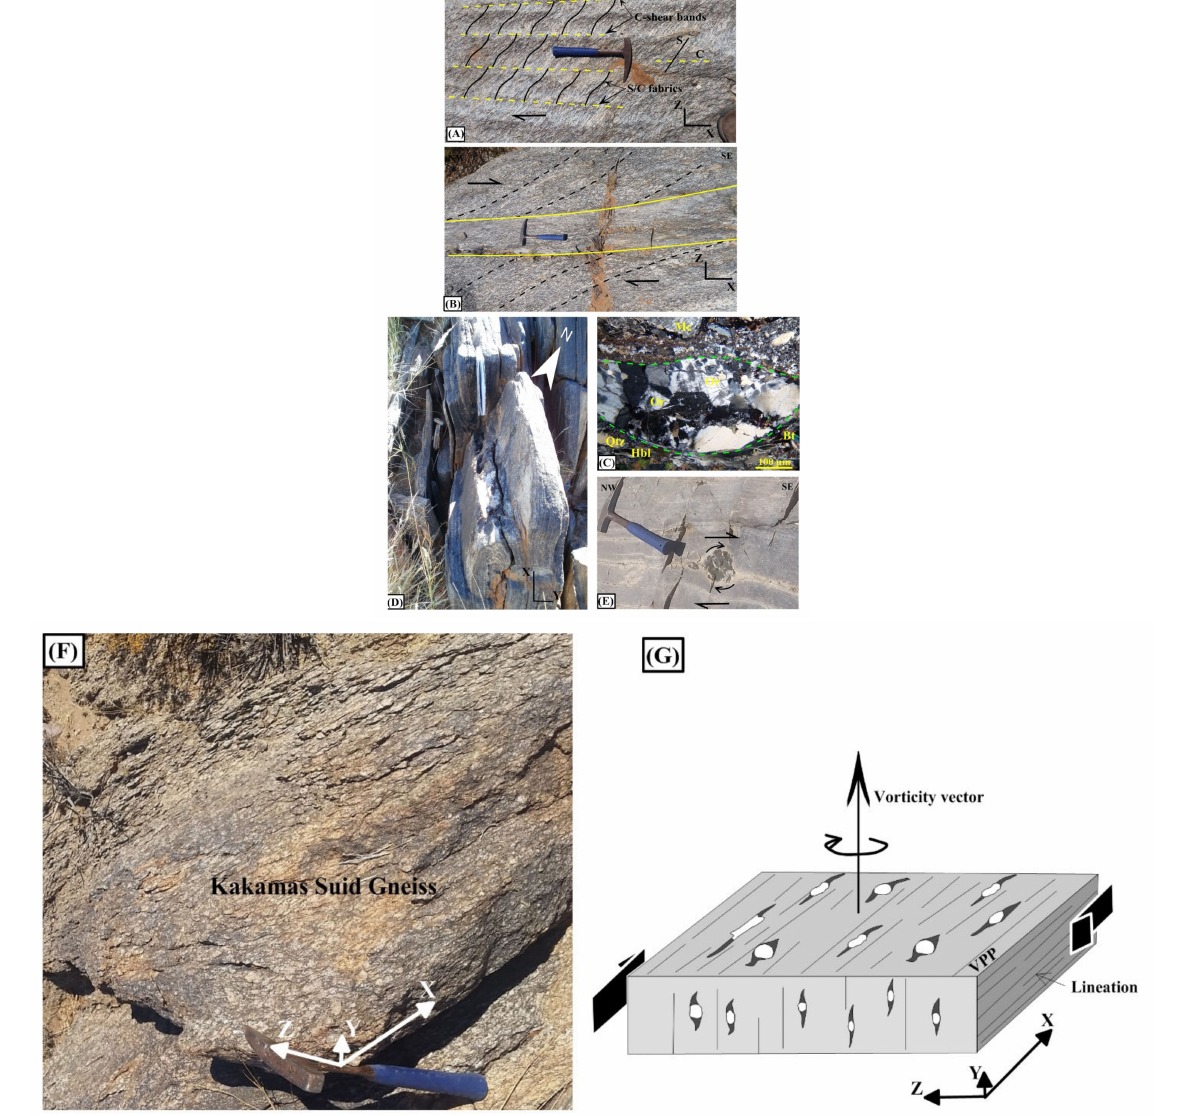
Figure 10. Structural and kinematic indicators along and adjacent to the Neusspruit Shear Zone. ( A ) S-C fabrics indicating dextral shear movement in the Kakamas Suid Gneiss along the Neusspruit Shear Zone. ( B ) Northwest-trending dextral shear zone in the Kakamas Suid Gneiss: Dextral shear movement is indicated by the progressive inflexion at the contact with the shear zone. ( C ) Photomicrograph of the Kakamas Suid Gneiss showing a mixture of very fine-grained crystals (top right-hand corner) indicative of shearing adjacent to the Neusberg Mountain, as well as well-delineated quartz/feldspar augen. Abbreviations: Qtz = Quartz; Or = Orthoclase; Mc = Microcline; Hbl = Hornblende; Bt = Biotite. ( D ) Boudinage traces in the calc-silicate-rich quartzite with long axis plunging in the XY-plane indicates an oblique sense of shear for the Neusspruit Shear Zone (white line is the edge of the notebook). ( E ) Highly epidotised δ -type plagioclase porphyroclast within the calc-silicate-rich quartzite. The tails contain traces of epidote. Dextral vorticity is indicated. ( F ) Outcrop of Kakamas Suid Gneiss showing well-defined mylonitic foliation illustrated in the XY-plane. ( G ) Sketch of monoclinic shear. The transport direction and, similarly, the vorticity profile plane (VPP) are parallel to the